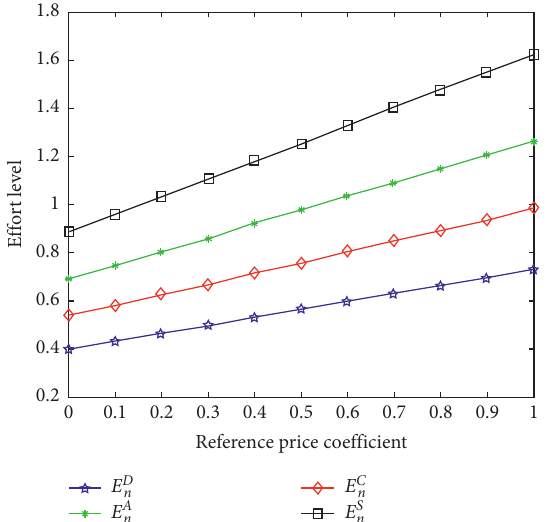
Figure 4: The impact of consumer reference price effects on effort level.